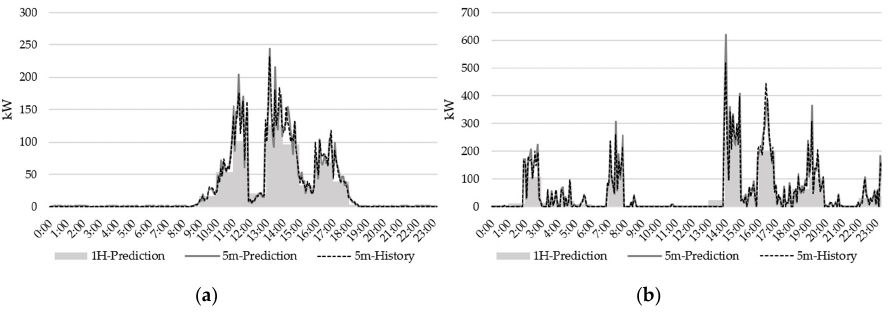
Figure 5. 1 h prediction for DA market bidding, 5 min prediction, and 5 min generation history for ID operation of ( a ) combined PV ( b ) WT.